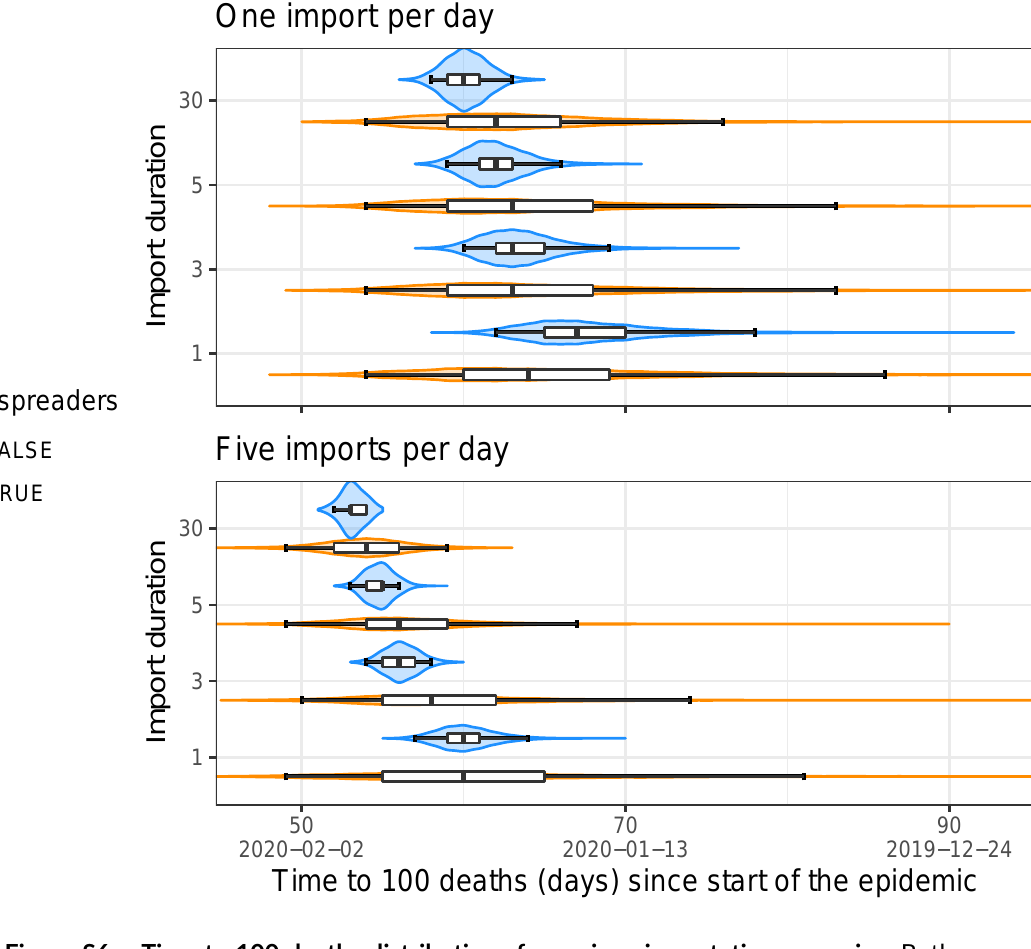
Figure S6 – Time to 100 deaths distributions for various importation scenarios. Both panel display the effect of an increase in the period of first cases import on the distri- bution of the time to 100 deaths. In the upper panel, 1 cases was imported whereas in the lower panel 5 case were imported. The boxplots show the following quantiles: 2.5%, 25%, 50 %, 75%, 97.5